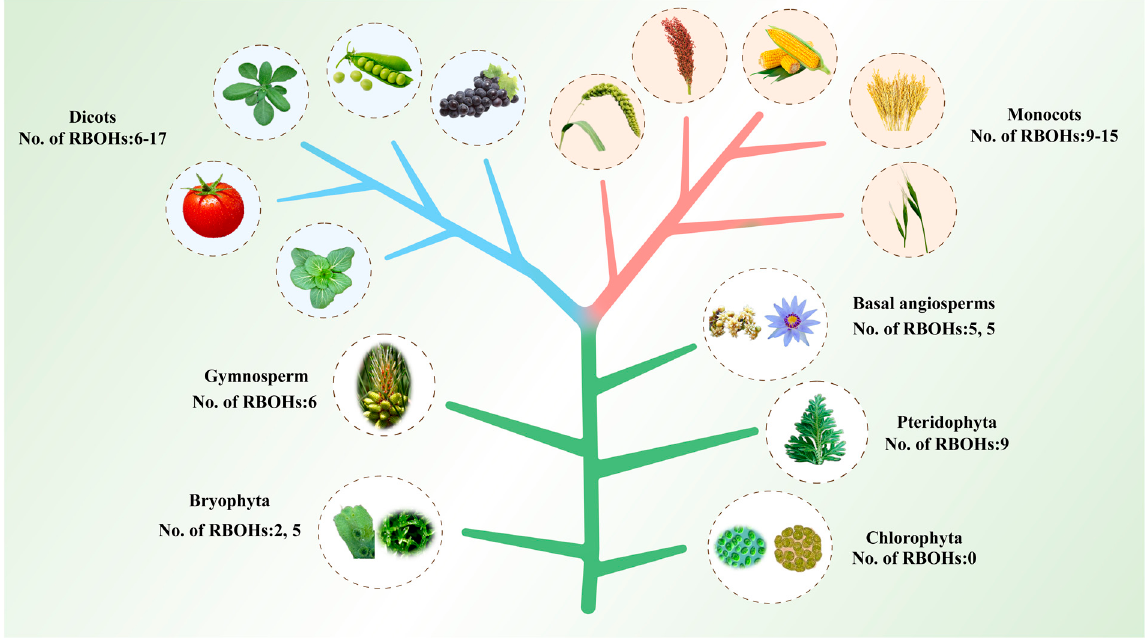
Figure 9. Model of occurrence of RBOHs in major plant species.